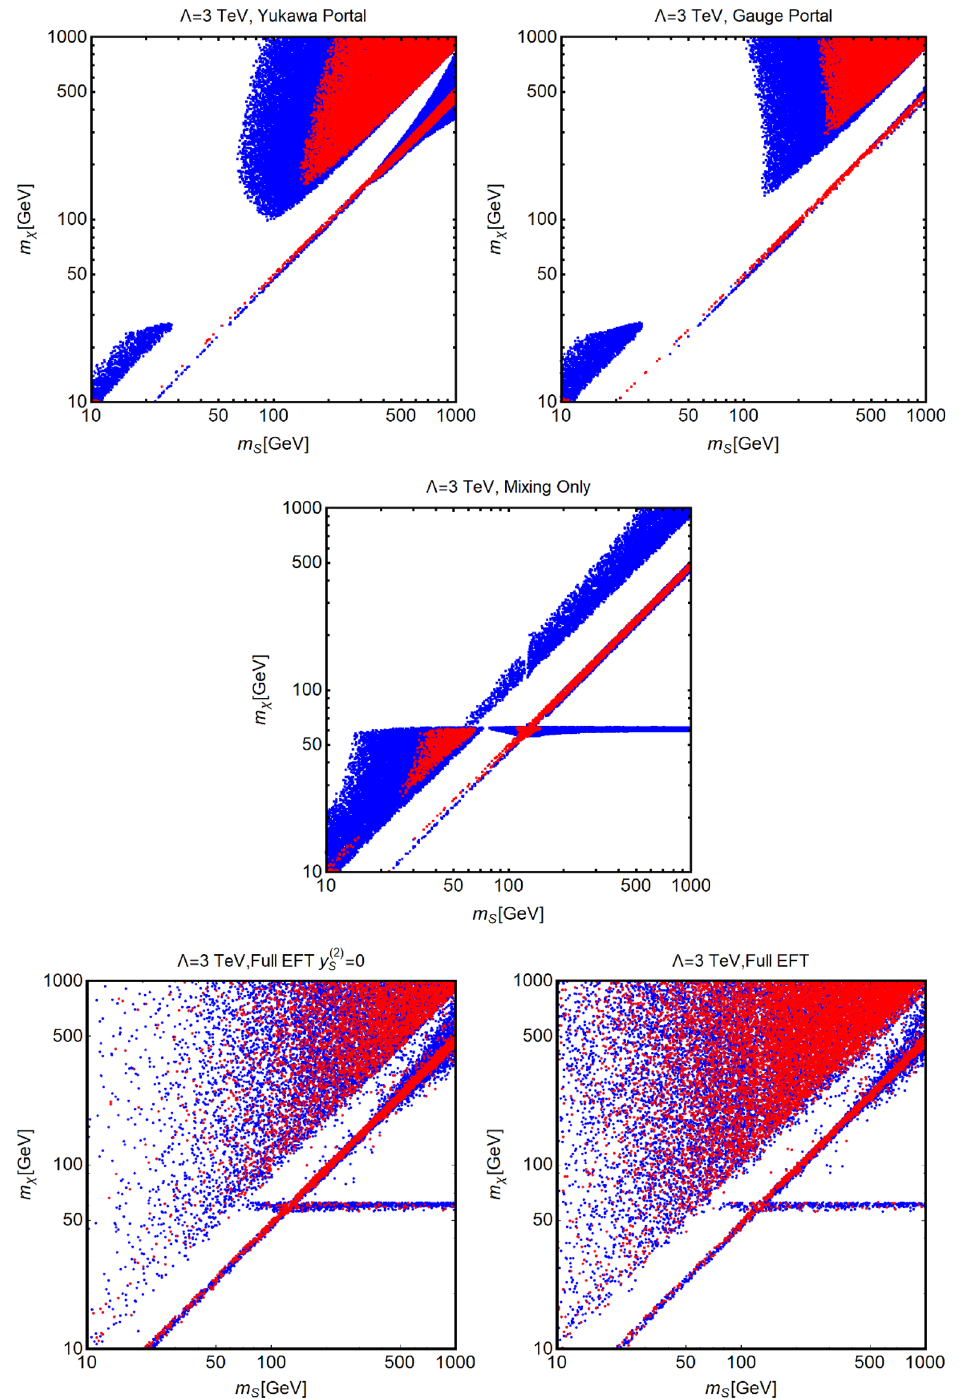
Figure 9 . Viable model points for the D = 5 (cid:13)avor-diagonal Yukawa portal (upper left), D = 5 scalar gauge portal (upper right), Higgs mixing portal (center), and full e DMeft with (lower right) and without (lower left) considering y (2) , in the m S (cid:0) m (cid:31) plane. While the blue points satisfy all S DM and collider bounds entertained before, the red points represent con(cid:12)gurations evading also a projected XENONnT exclusion.